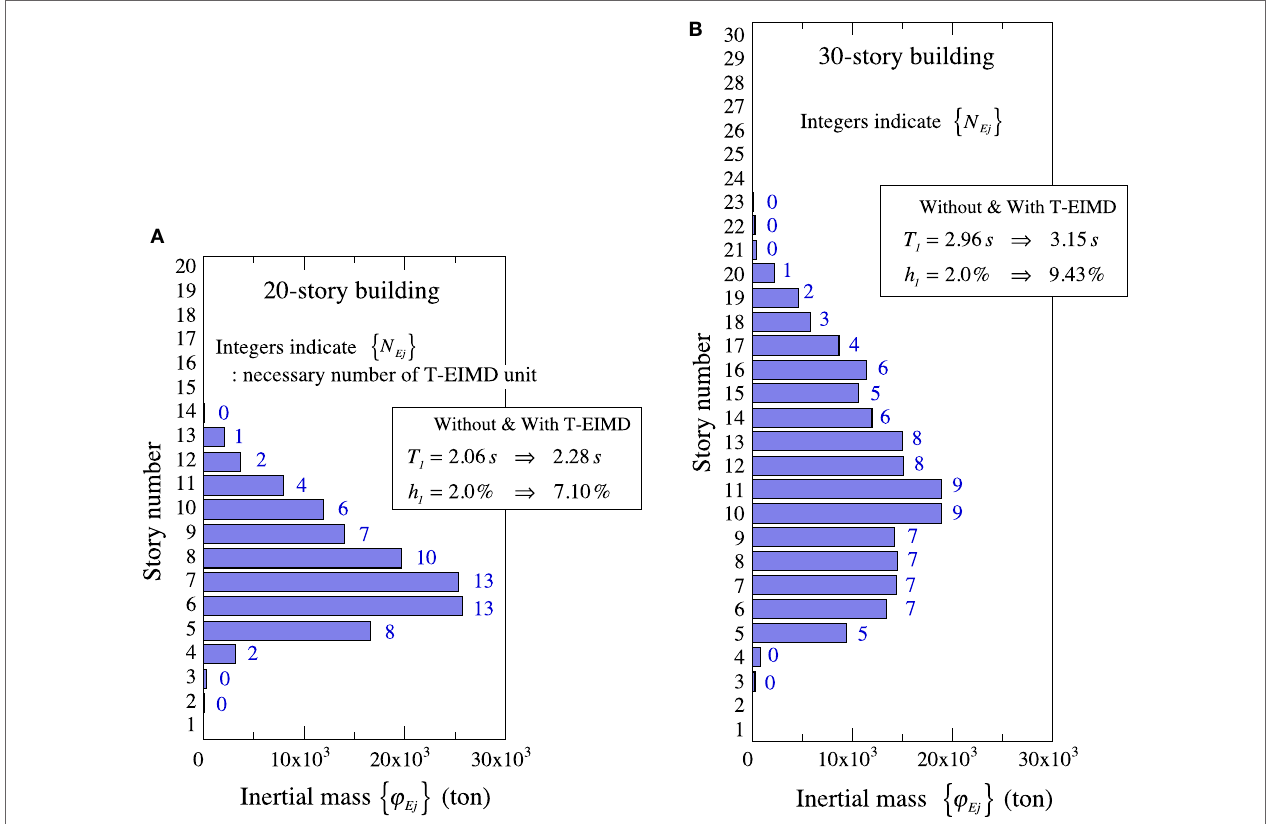
FIGURE 12 | Obtained story-wise distribution of inertial mass and necessary number of T-tuned electromagnetic inertial mass dampers in 20- and 30-story buildings for peak story drift angle of 1/150 . (A) 20-story building, and (B) 30-story